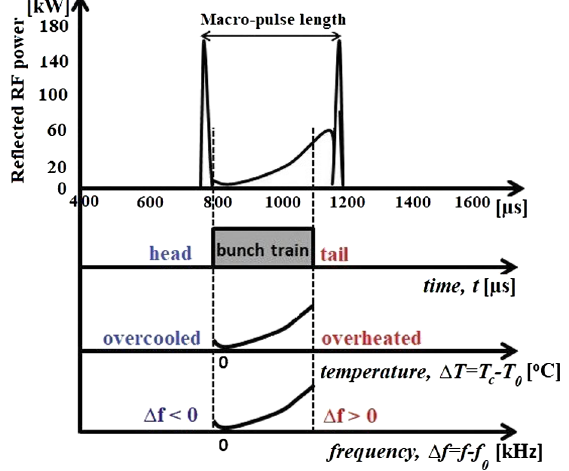
FIG. 13. Measured bunch position change along a 240 μ s train at ∼ 5 . 27 meters downstream from cathode. The solenoid current is fixed. Green curve: a polynomial fit to the